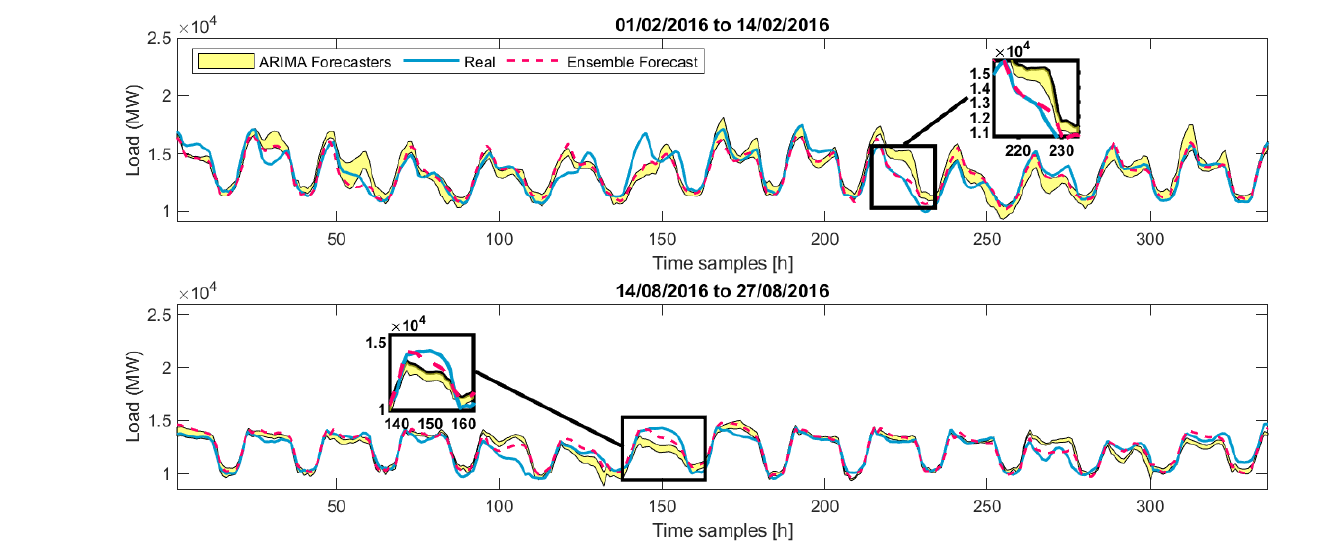
Figure 5. Load forecasts vs. real load (New England region), where the ARIMA forecasters area in yellow represents the region mapped by the forecasts of 15 different ARIMA models, the stacking ensemble forecast is illustrated in a dashed magenta line and the real (target) load is illustrated in a solid blue line.